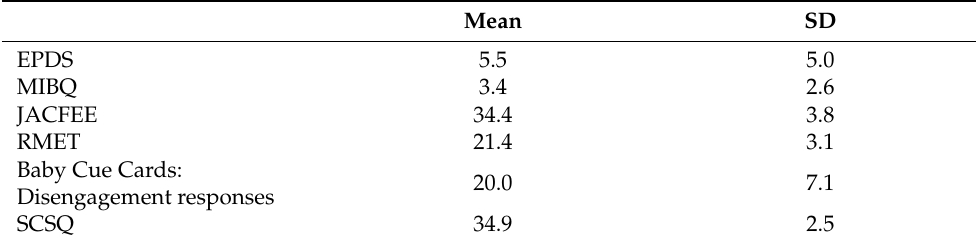
Table 2. Average scores on the EPDS and MIBQ and on the social cognitive